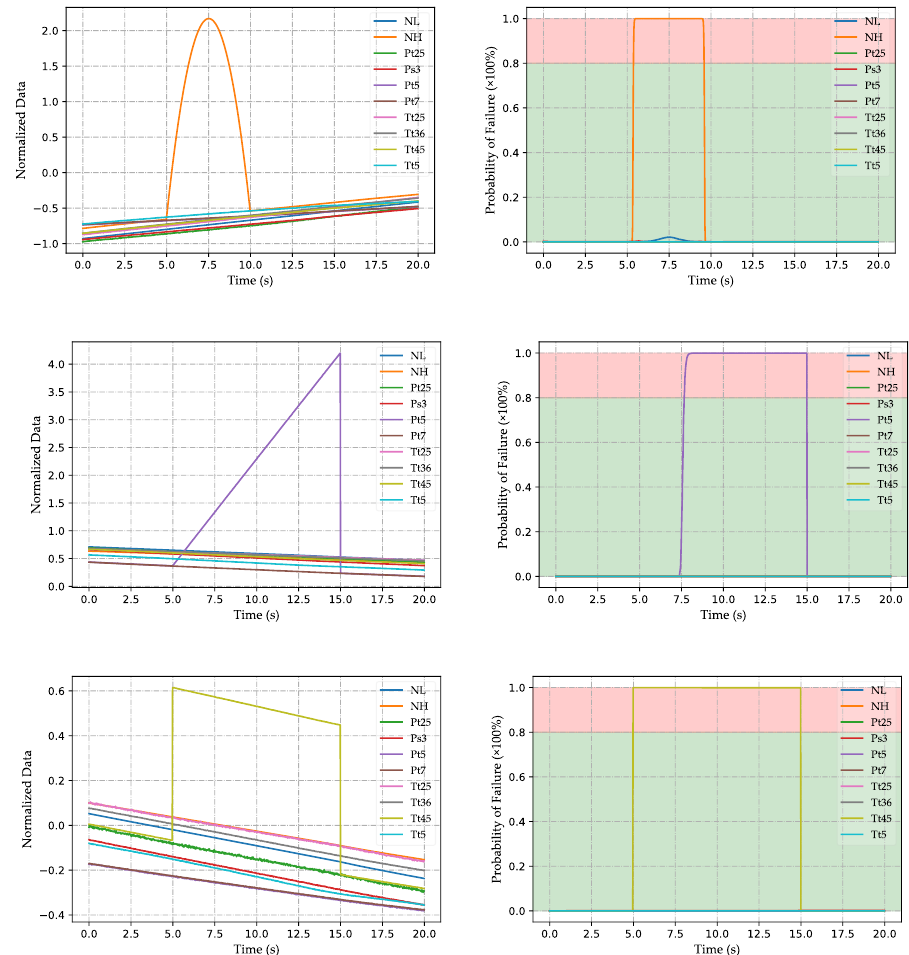
Figure 12. Detection of single sensor failure in transition state.